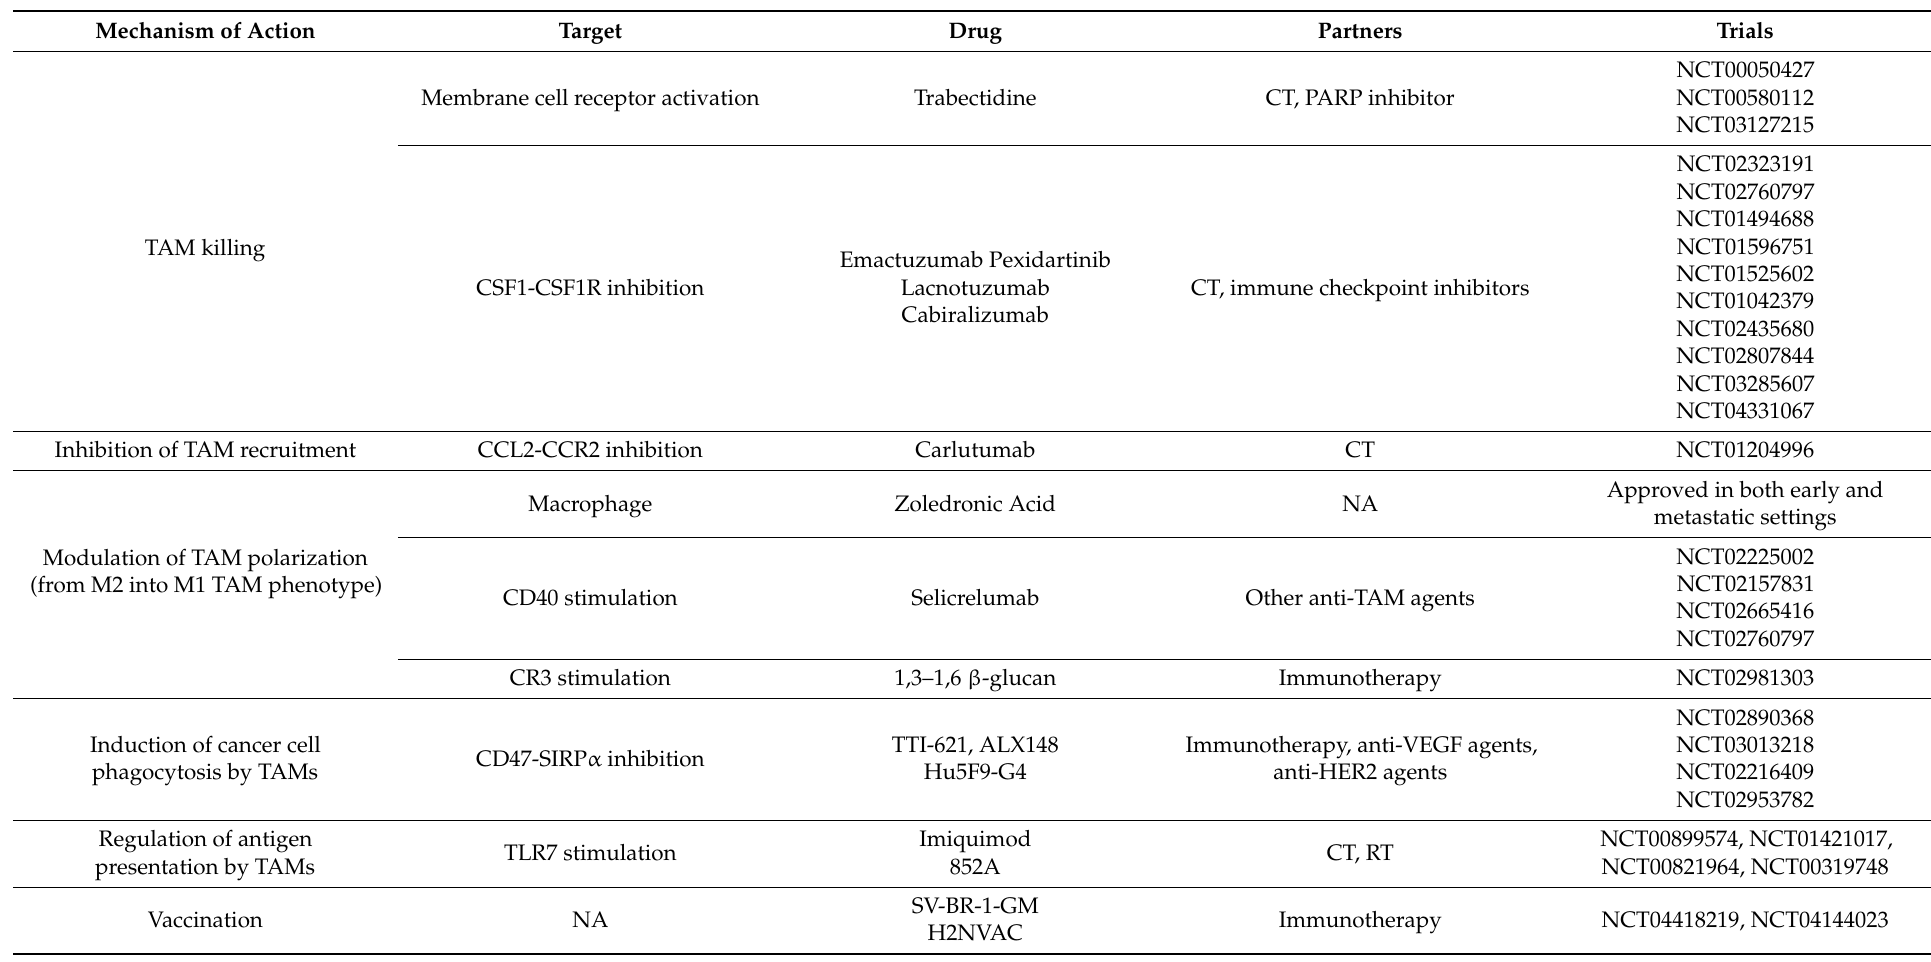
Table 3. Summary of strategies targeting TAMs which are currently under investigation in breast cancer preclinical and clinical